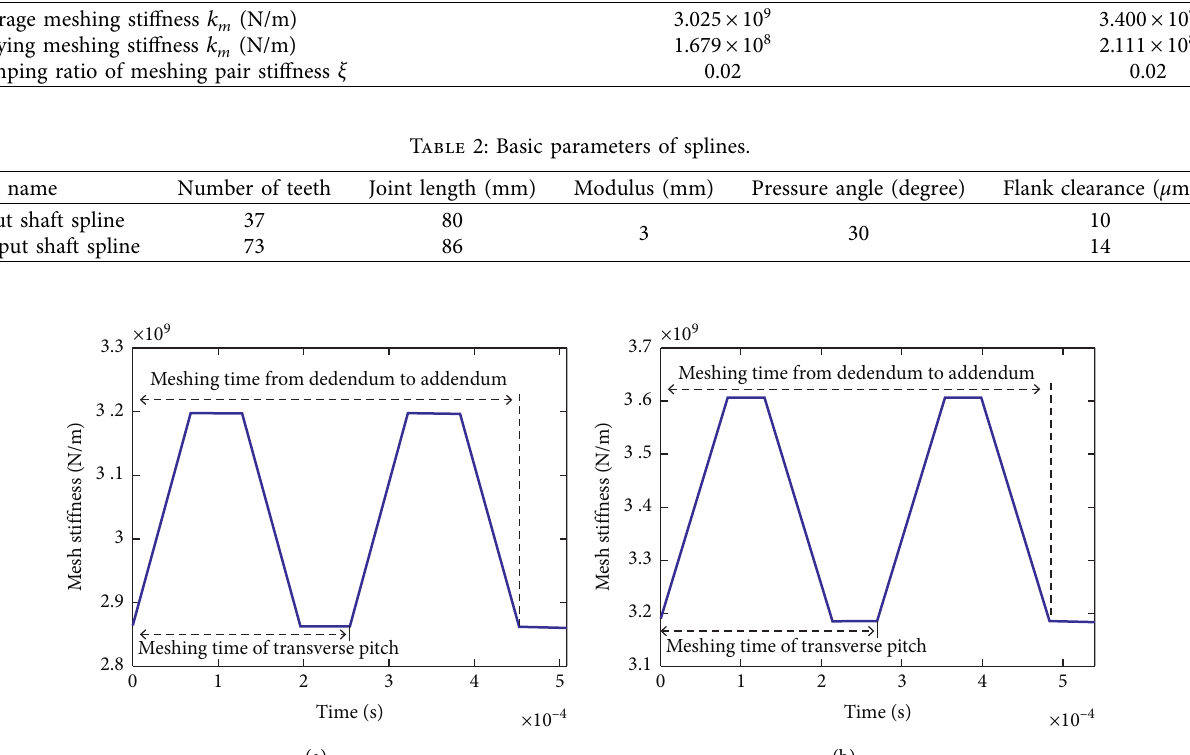
Figure 6: Mesh stiffness of external and internal gear meshing pair. (a) External mesh stiffness, (b) internal mesh stiffness.